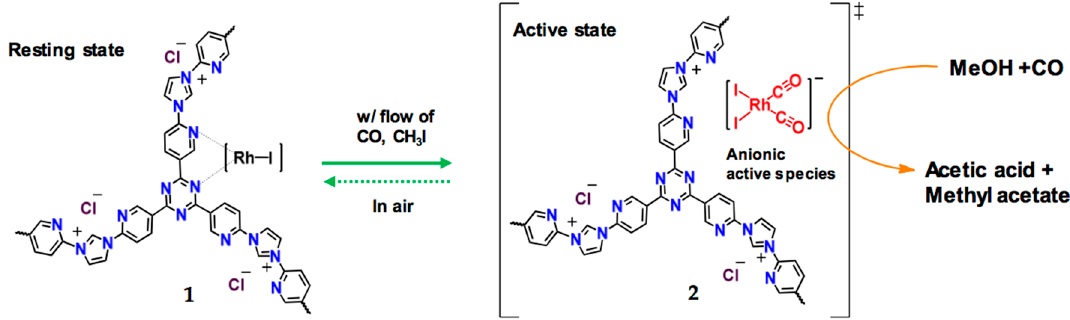
Figure 8. Structural representation of the Rh-bpim-CTF catalyst in resting state ( 1 ), and ( 2 ) the suggested structure of the in situ generated active state (Reprinted with permission from [54]. Copyright 2018, Royal Society of